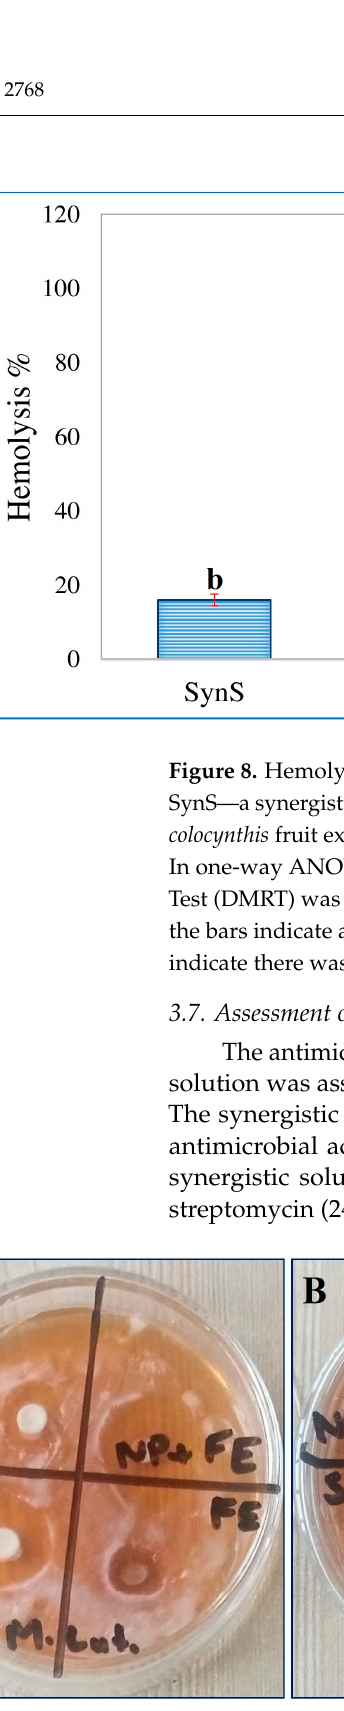
Figure 9. Antimicrobial activity of CaONPs, C. colocynthis fruit extracts and their synergistic solution against Micrococcus luteus ( A ), Vibrio cholerae ( B ), and Vibrio parahaemolyticus ( C ). NP—calcium oxide nanoparticles; FE— C. colocynthis fruit extracts; S—streptomycin; NP + FE—synergistic solution of calcium oxide nanoparticles and C. colocynthis fruit extracts.